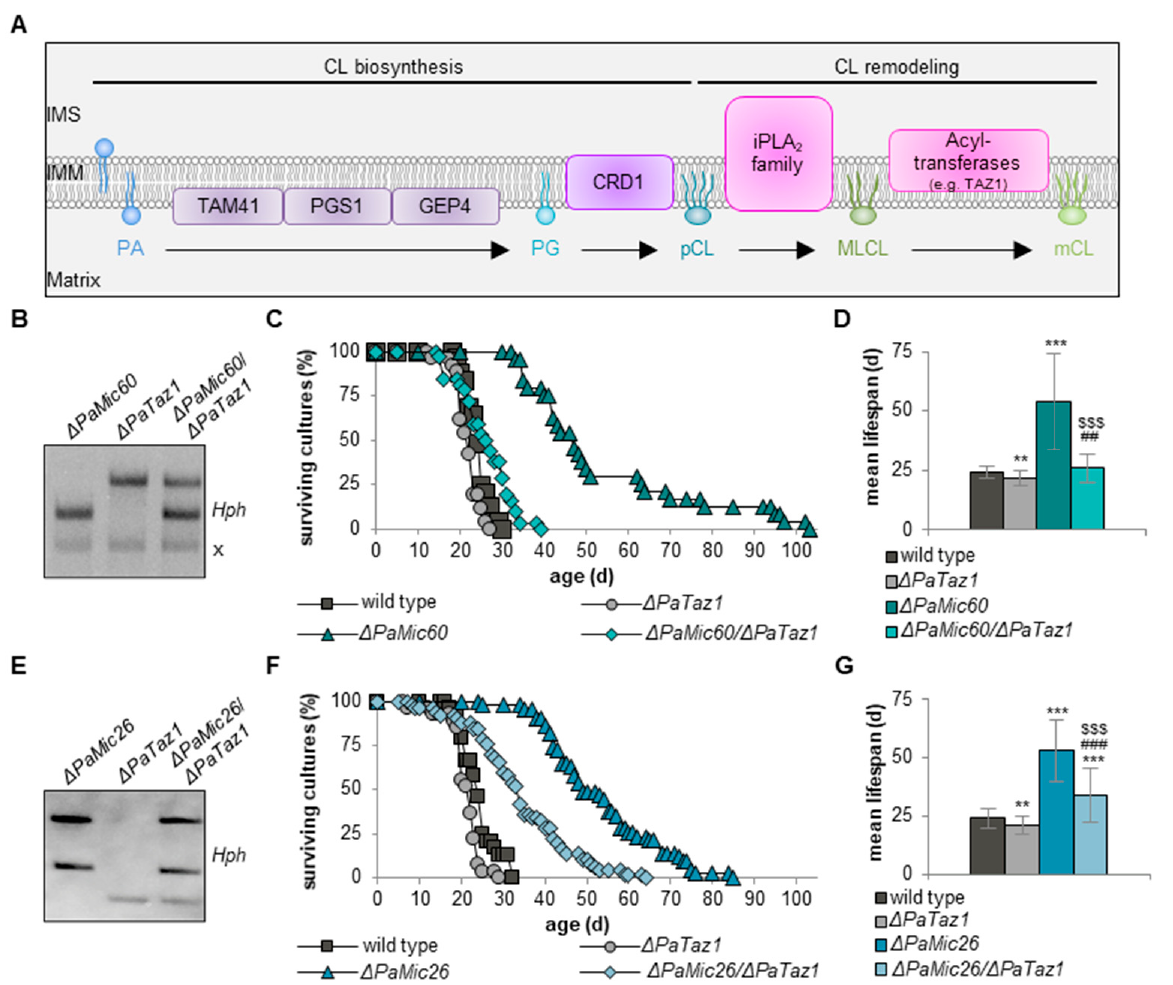
Figure 3. Ablation of PaTAZ1 affects longevity of MICOS mutants. ( A ) Scheme depicting compo- nents of CL biosynthesis and remodeling in the inner mitochondrial membrane. IMS: